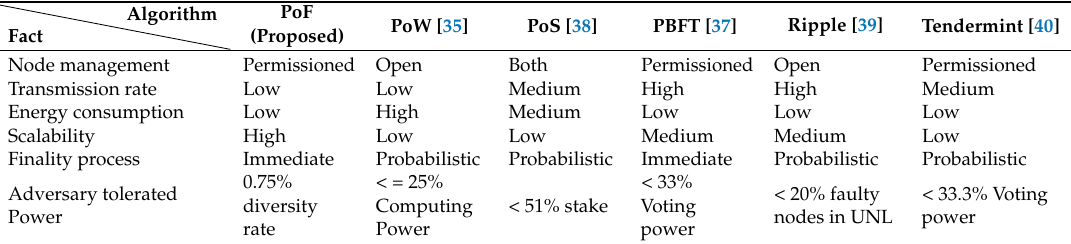
Table 5. Comparison of proof of familiarity (PoF) with other consensus